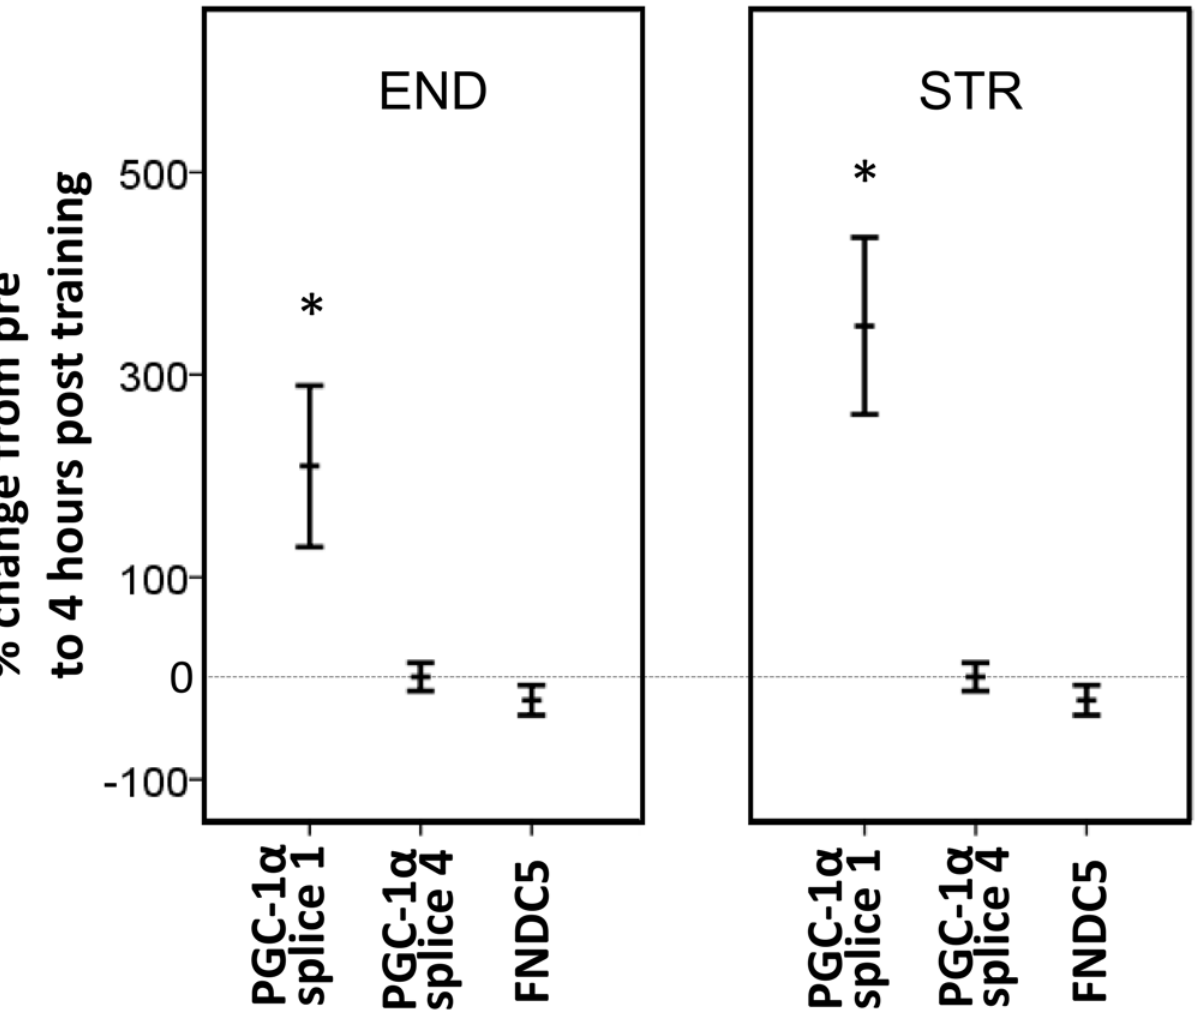
Fig 4. Changes in gene expression. Relative changes in gene expression of irisin-related genes following singular sessions of intense endurance exercise (END) or heavy strength training (STR). Muscle biopsies were sampled 4h post exercise. Data are mean values ± SEM. * = p (cid:3) 0.05.